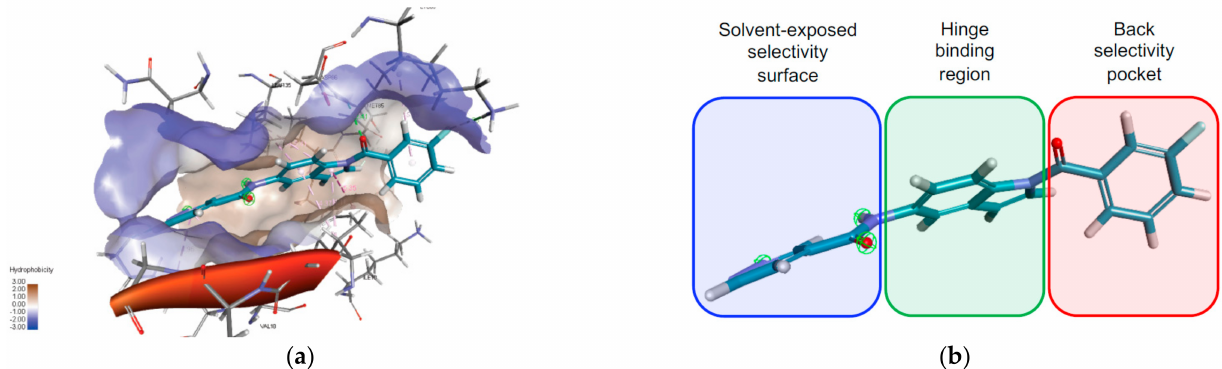
Figure 4. Binding mode of compound 15l into CDK-1/cyclin B active site (PDB ID: 5LQF); ( a ): 3D visualization shows the orientation of compound 15l binding motifs in the main regions of the active site; ( b ): graphical illustration of orientation of compound 15l binding motifs in the CDK-1/cyclin B active site. Indole-based central motif occupied hinge binding region (green color), 3-fluorophenyl ring aligned into the back groove (red color) and terminal pyridazine ring travelled out towards solvent-exposed surface (blue color).